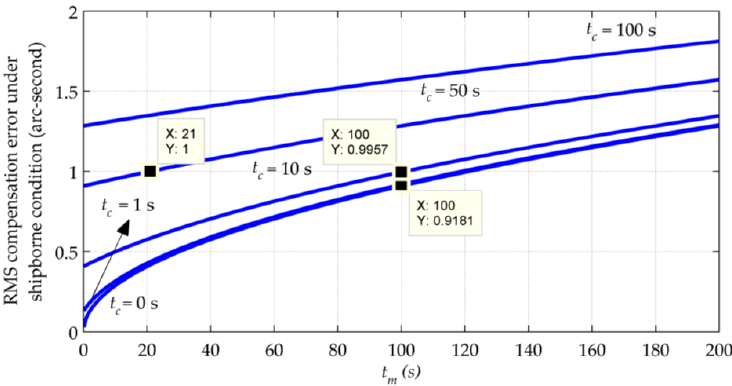
Figure 6. RMS compensation errors vs. update interval and computing time delay under the shipborne condition.